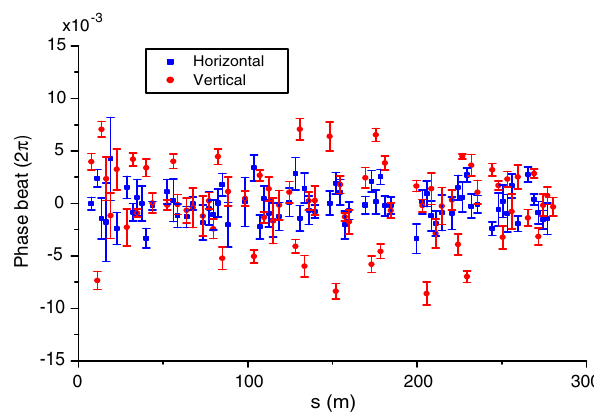
FIG. 7. Residual phase-beat. The rms value of the residual phase-beat is 0.0015 and 0.0036 in the horizontal and vertical planes, respectively. The error bars indicate the statistical error over four measurements.